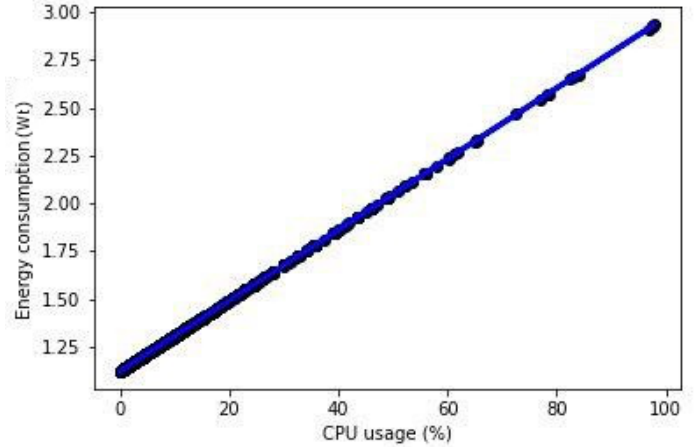
Figure 6. Representation of the relationship between energy consumption energy consumption (EC) and CPU